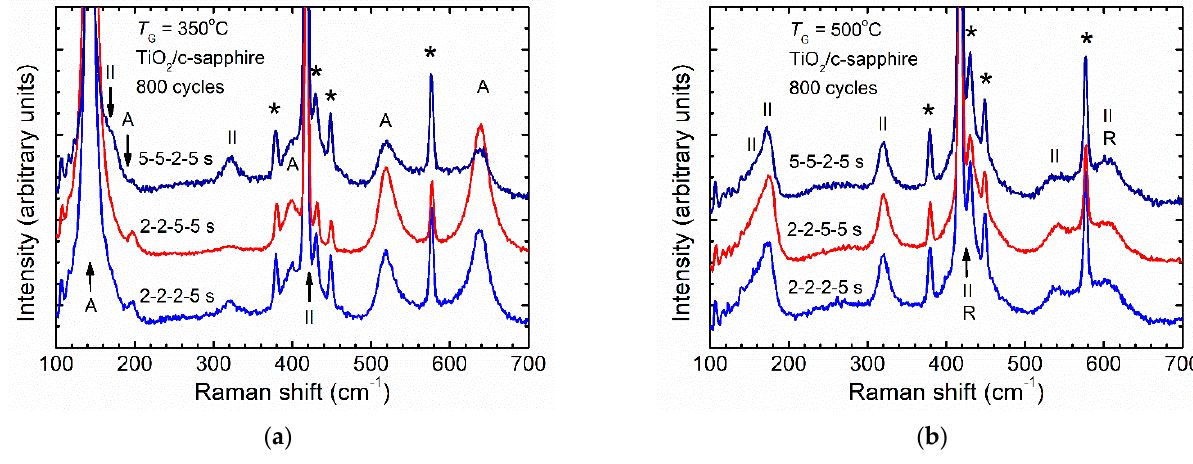
Figure 9. Raman spectra of TiO 2 films grown on c-sapphire at ( a ) 350 °C and ( b ) 500 °C using different ALD cycle time parameters and shown at respective spectra. The number of ALD cycles used to deposit each film was 800. The film thicknesses were ( a ) 36–44 nm and ( b ) 24–26 nm. Raman bands attributed to anatase (A), rutile (R), TiO 2 -II (II), and substrates (*) are marked.